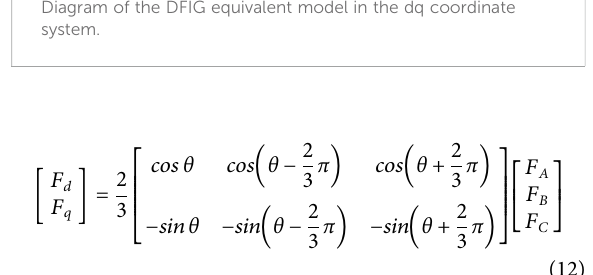
FIGURE 4 Diagram of the DFIG equivalent model in the dq coordinate